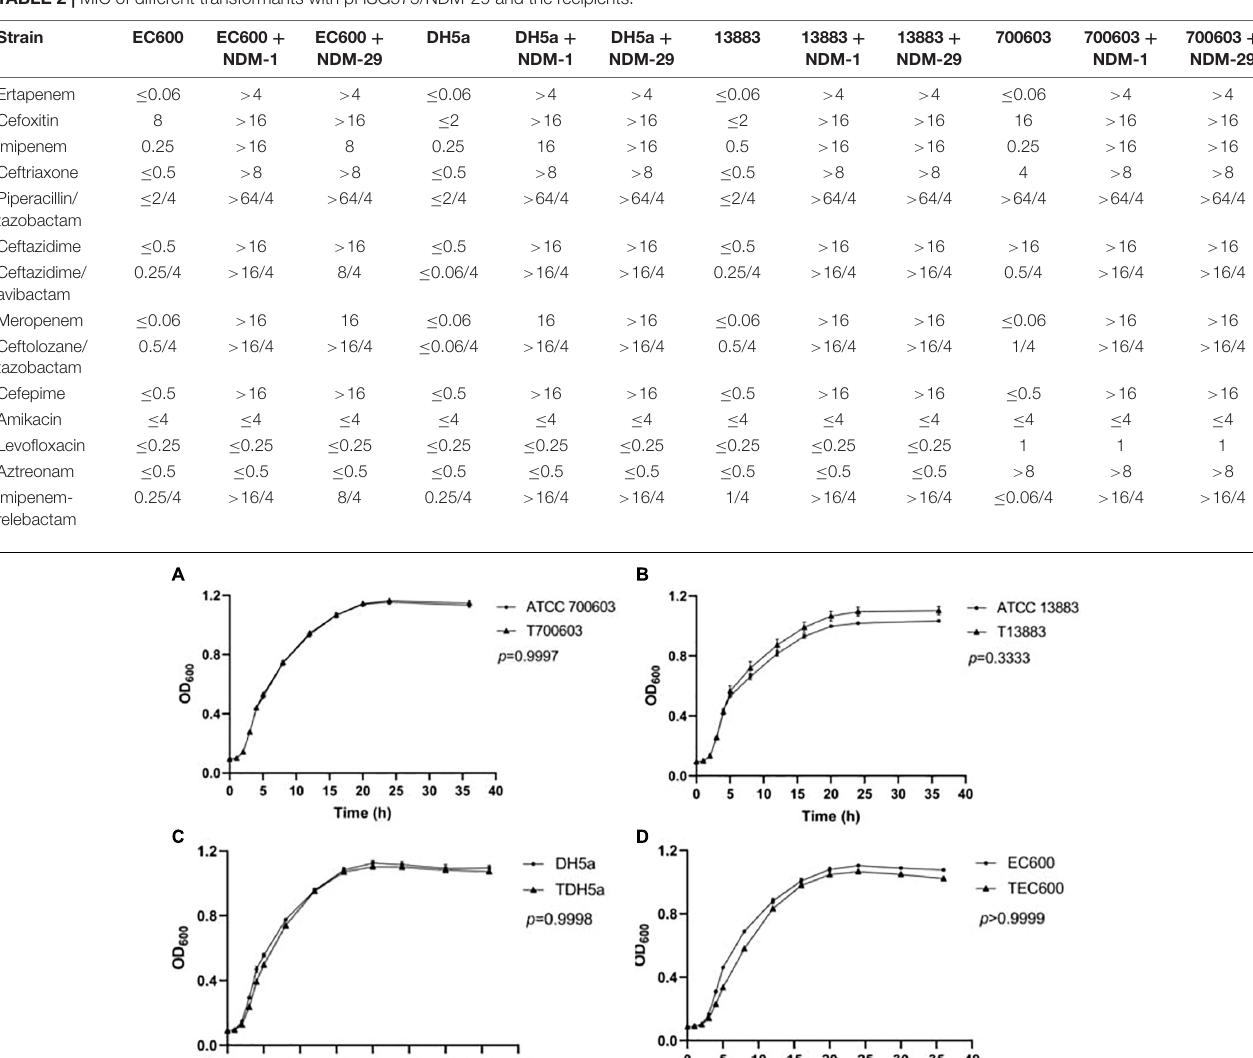
TABLE 2 | MIC of different transformants with pHSG575/NDM-29 and the recipients.